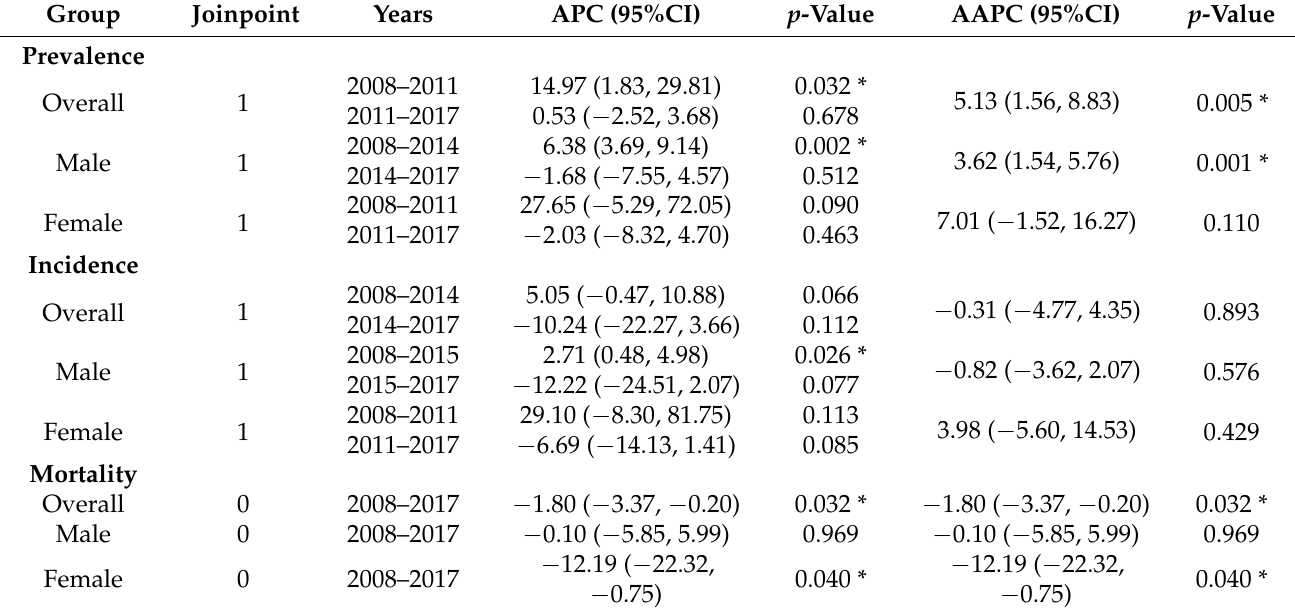
Table 2. Results of the joinpoint regression on the age-adjusted prevalence, incidence, and mortality rates of the HCC from 2008 to 2017.